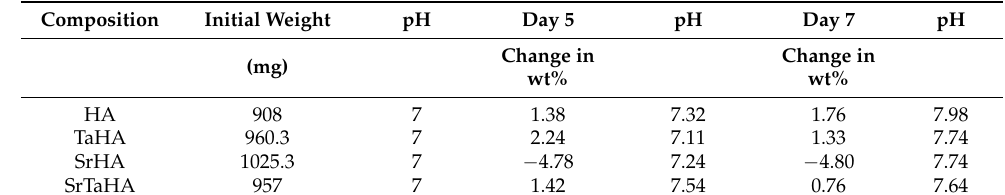
Table 5. Weight change ratio of the samples.